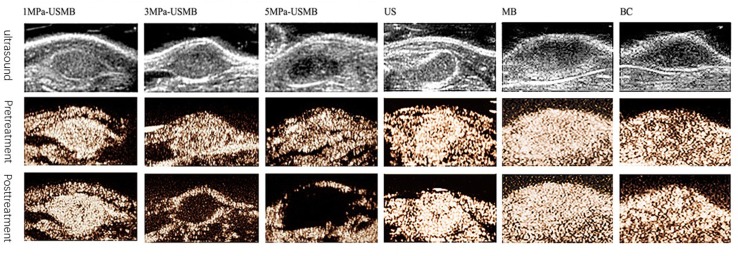
Microbubbles were filled into the tumor rapidly and evenly, and no filling defect was found in all groups before treatment. After treatment, enhancement of the tumor was marginally stronger than pretreatment in low-intensity ultrasound combined with microbubble (1MPa-USMB) group, but in medium-intensity ultrasound combined with microbubble (3MPa-USMB) group, the contrast-enhanced ultrasound (CEUS) showed a filling defect in the center of the tumor with a ring-shaped enhancement around the tumor, and the filling defect was larger in high-intensity ultrasound combined with microbubble (5MPa-USMB) group than in 3MPa-USMB group. The blood perfusion after treatment in US group, MB group, and BC group were similar, and the microbubbles were filled into the tumor quickly and completely.